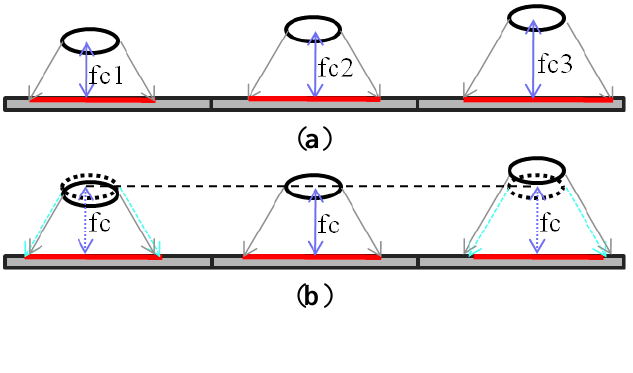
Figure 8. Image resize. ( a ) Different focal lengths. ( b ) After